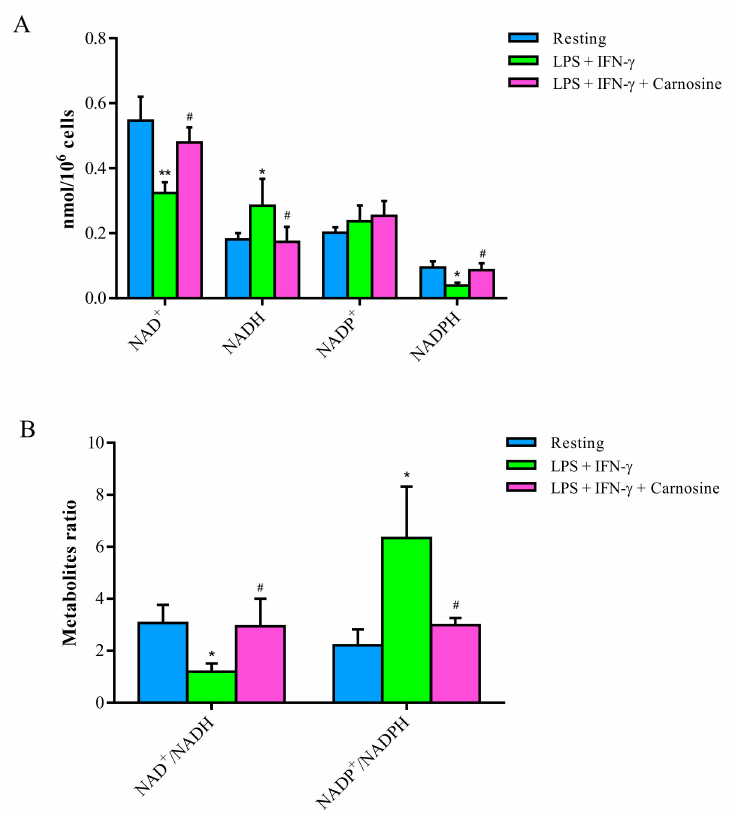
Figure 4. Changes in the concentrations of ( A ) nicotinic coenzymes (NAD + , NADH, NADP +